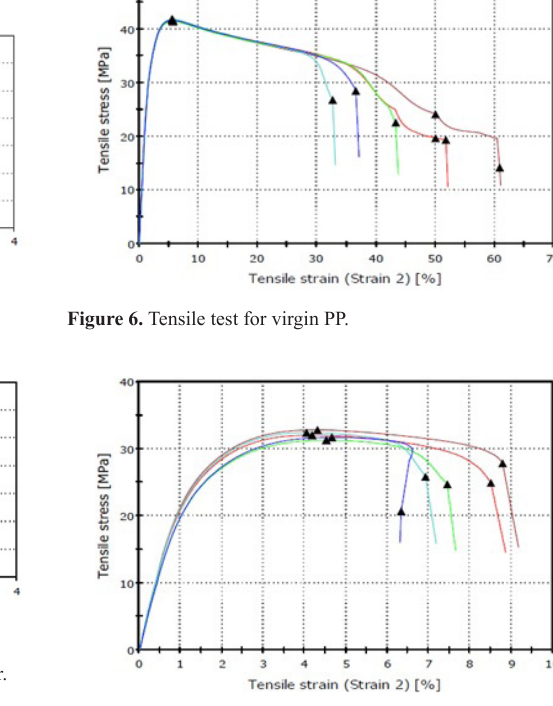
Figure 7. Tensile test for the composite PP 15wt% fiber.